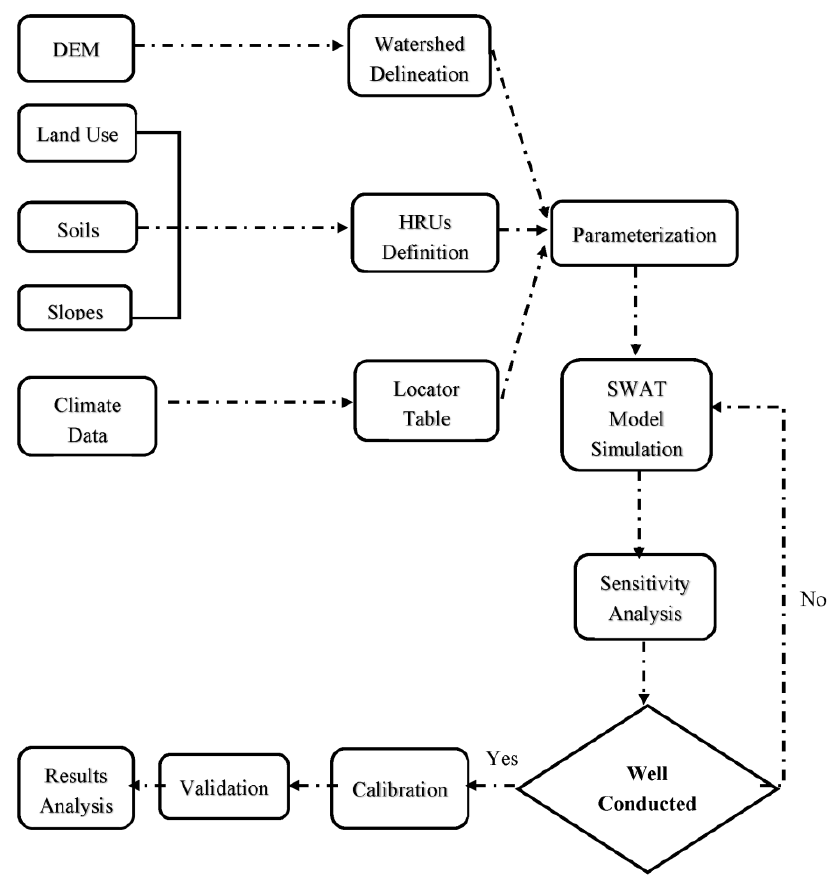
Figure 3. Flow Chart of the Steps in the SWAT Model Application in the Black Volta Basin.